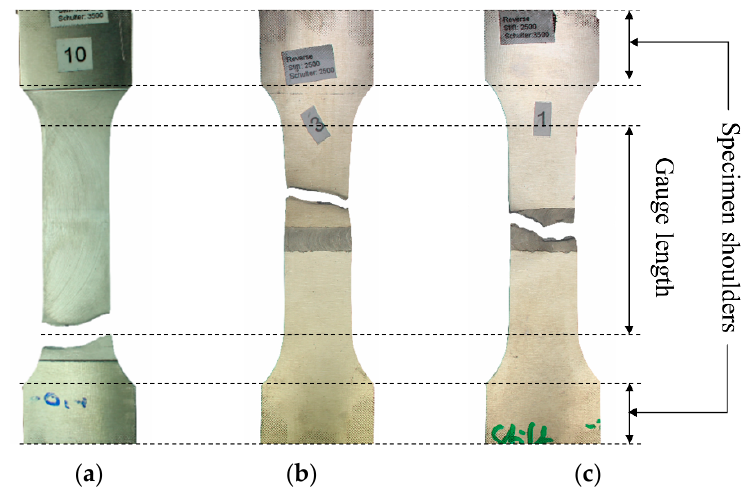
Figure 9. Examples of fractures ( a ) near the specimen shoulder, ( b ) in the base material and ( c ) in the middle.